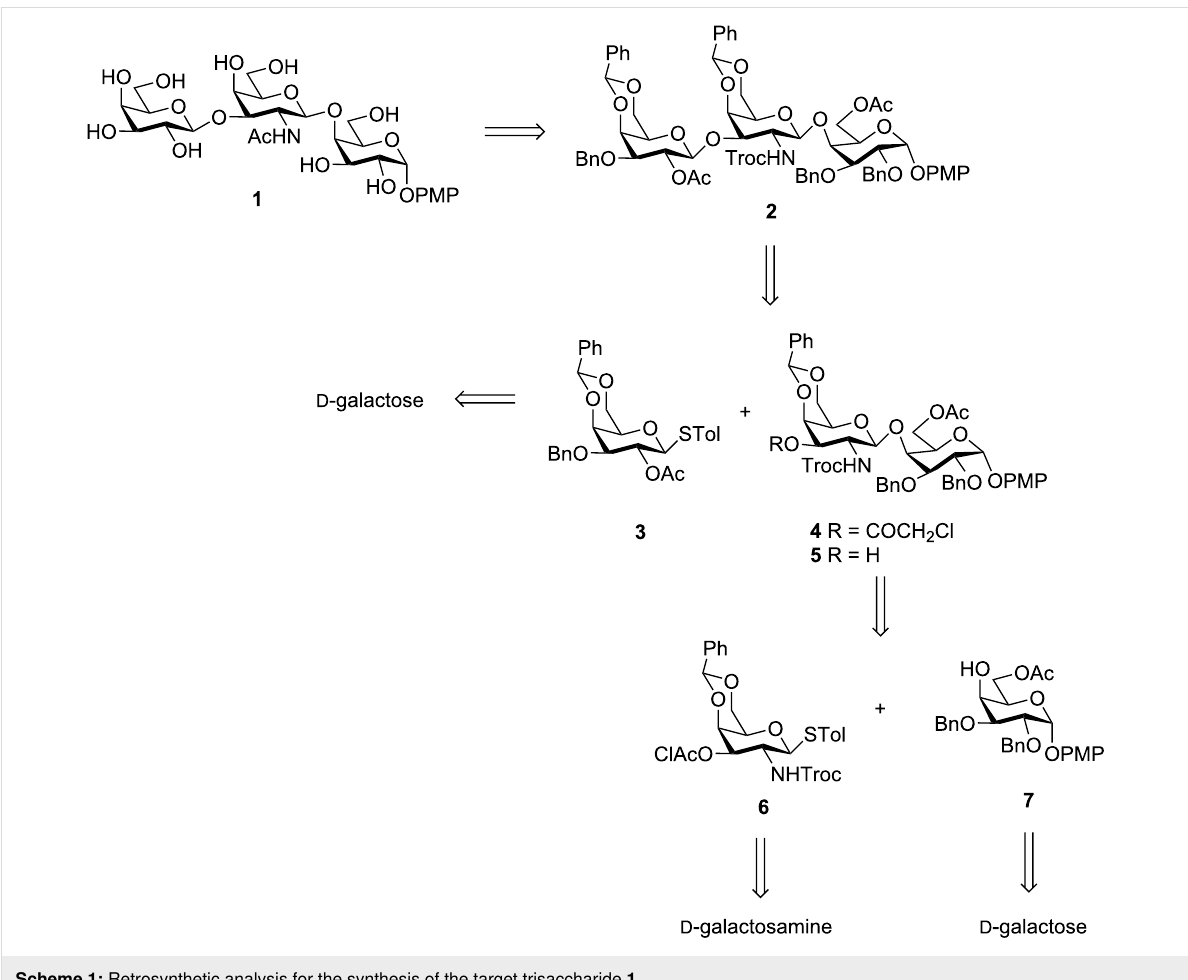
Scheme 1: Retrosynthetic analysis for the synthesis of the target trisaccharide 1 .